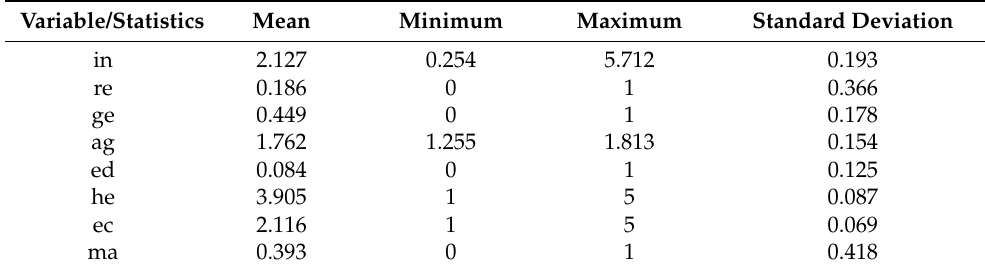
Table 2. Results of fundamental properties of investigated variables.